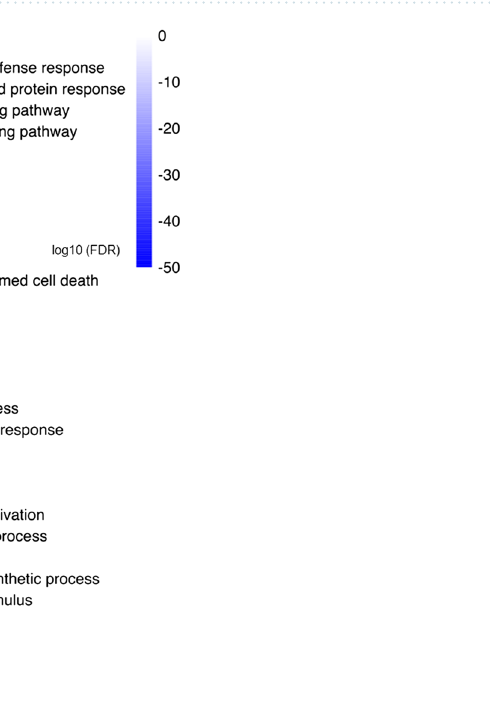
Figure 3. DEGs identified in the local cotyledon tissue of DH24288 inoculated with a virulent or avirulent Lm isolate, and in remote (non-inoculated) cotyledons at 7 dpi. ( a ) DEGs between local samples of susceptible (COM-local) and resistant (INC-local) reactions. ( b ) DEGs between remote cotyledon samples, COM-remote and INC-remote, on plants with locally susceptible and resistant reactions, respectively. ( c ) Up-regulated and down-regulated DGEs in each of the samples.